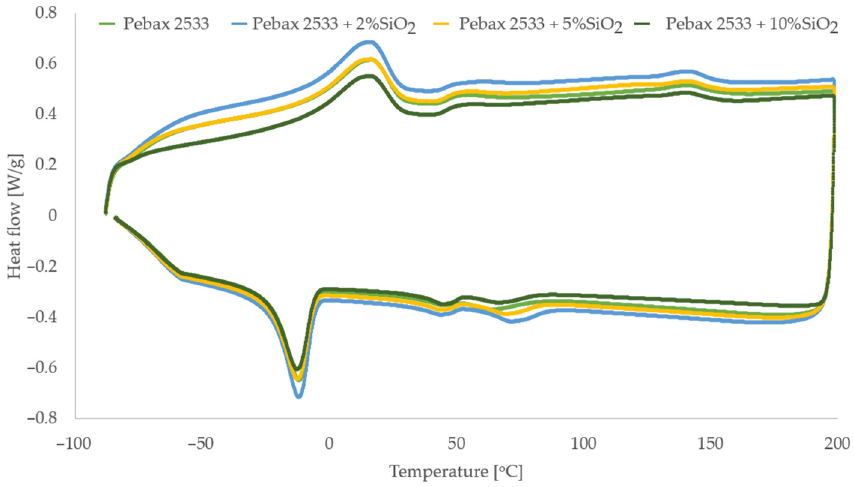
Figure A2. DSC thermogram for membranes containing SiO 2 in different concentrations.